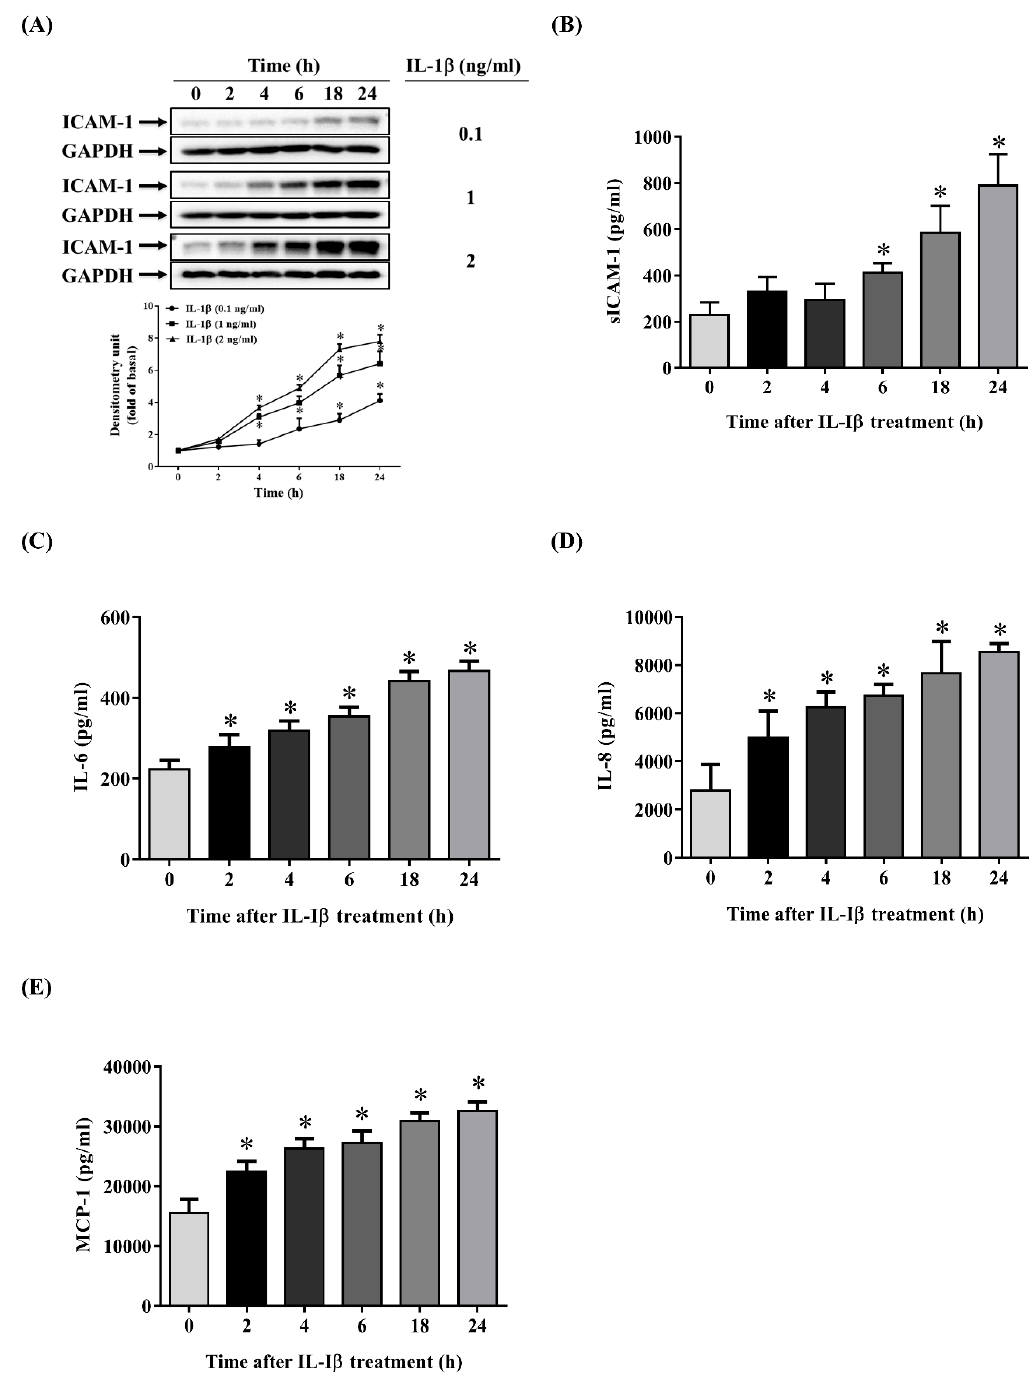
Figure 1. Interleukin-1 β (IL-1 β ) induces the expression of intercellular adhesion molecule-1 (ICAM-1), soluble ICAM-1 (sICAM-1), IL-6, IL-8 and monocyte chemoattractant protein-1 (MCP-1) in human retinal pigment epithelial (ARPE-19) cells. ( A ) IL-1 β at concentrations of 0.1–2 ng / mL was used to stimulate ARPE-19 cells for the indicated times. The protein expression of ICAM-1 was analyzed by Western blotting (top panels) and quantified by Image Lab software (lower panels). ( B ) The levels of sICAM-1, ( C ) IL-6, ( D ) IL-8 and ( E ) MCP-1 in ARPE-19 cells were measured using Enzyme-Linked Immunosorbent Assay (ELISA) after stimulation with 1 ng / mL IL-1 β for the indicated times. The data are expressed as mean ± SD of three independent experiments. * p < 0.05 compared with the basal